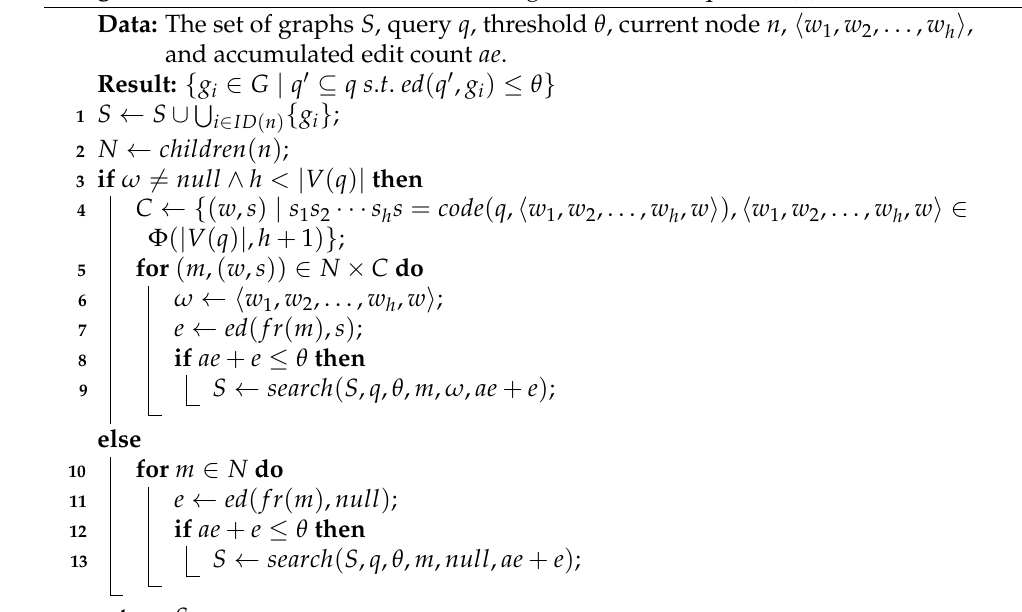
Algorithm 4: Code Tree Search for Finding Solutions to Equation